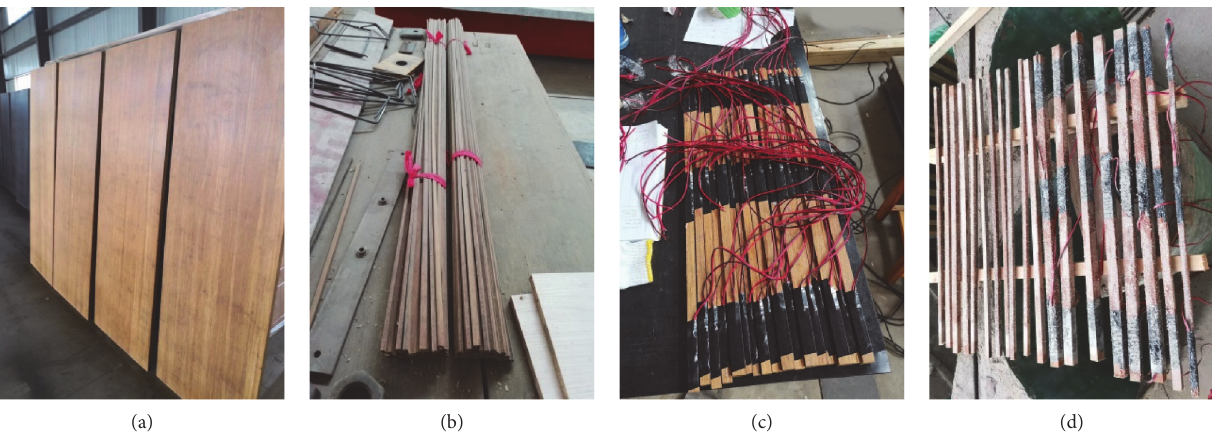
Figure 2: Production process of bamboo scrimber strips: (a) bamboo boards, (b) bamboo strips, (c) gluing strain gages, and (d) gluing